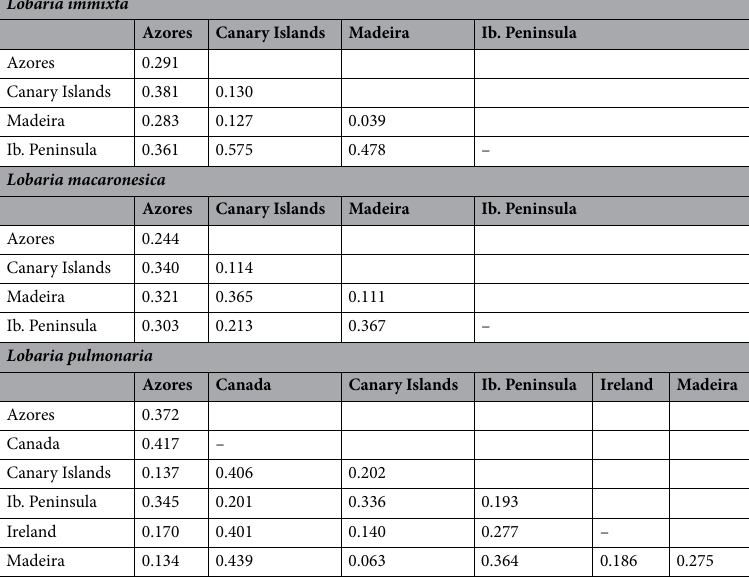
Table 2. Pairwise F ST values for each geographic region for three lichen fungi Lobaria immixta , L. macaronesica , and L. pulmonaria collected from sites in Macaronesia and in adjacent areas. All values for differentiation between archipelagos were statistically significant ( p < 0.001). Values on the diagonal, i.e. within geographic regions, represent average pairwise F ST values between populations. These were calculated for regions including more than two